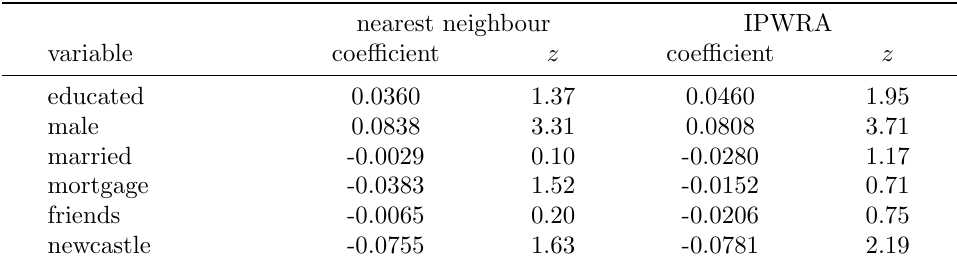
Table 3: Average treatment